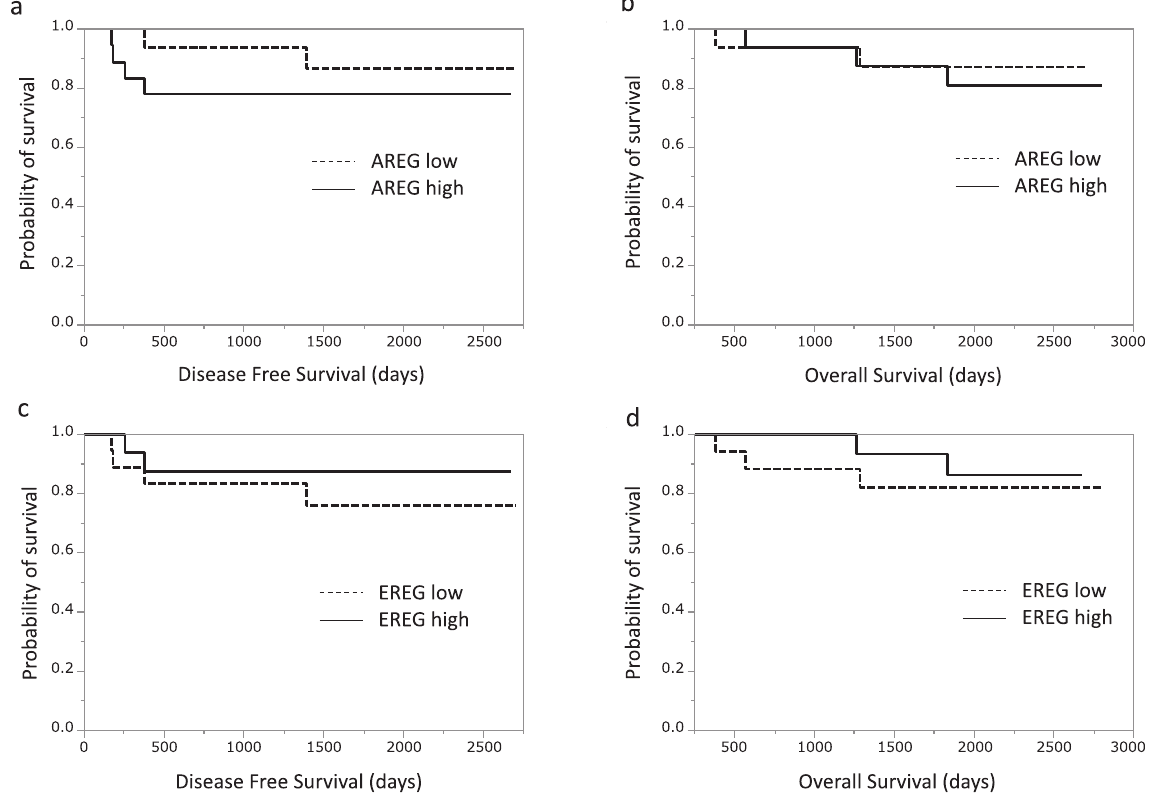
Figure 4. DFS and OS in patients with wild-type RAS, stage III colorectal cancer according to AREG and EREG